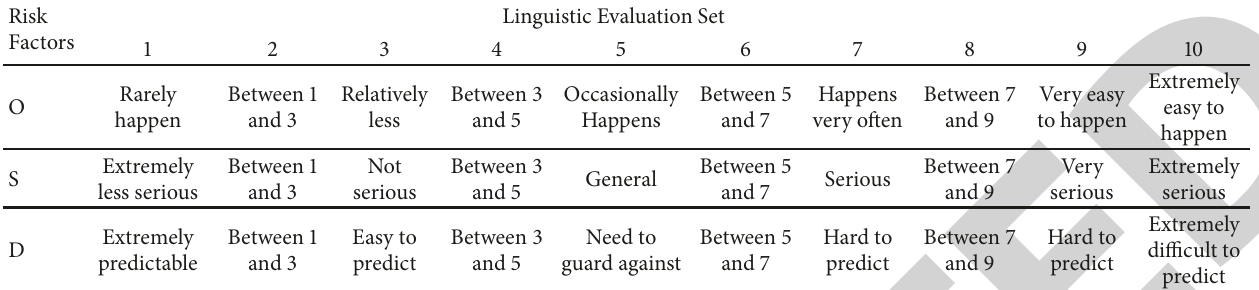
Table 2: Collections of linguistic terms for risk factors.